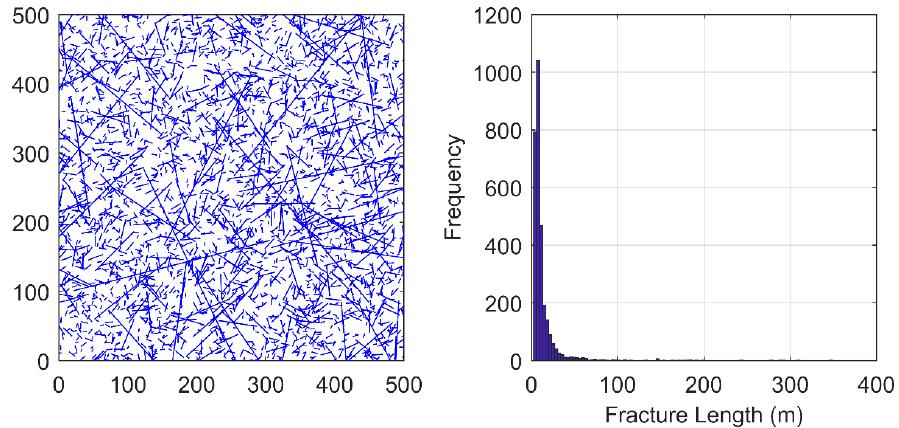
Figure 17. Case 3: DFN ( left ) and its histogram of the fracture length distribution ( right ).